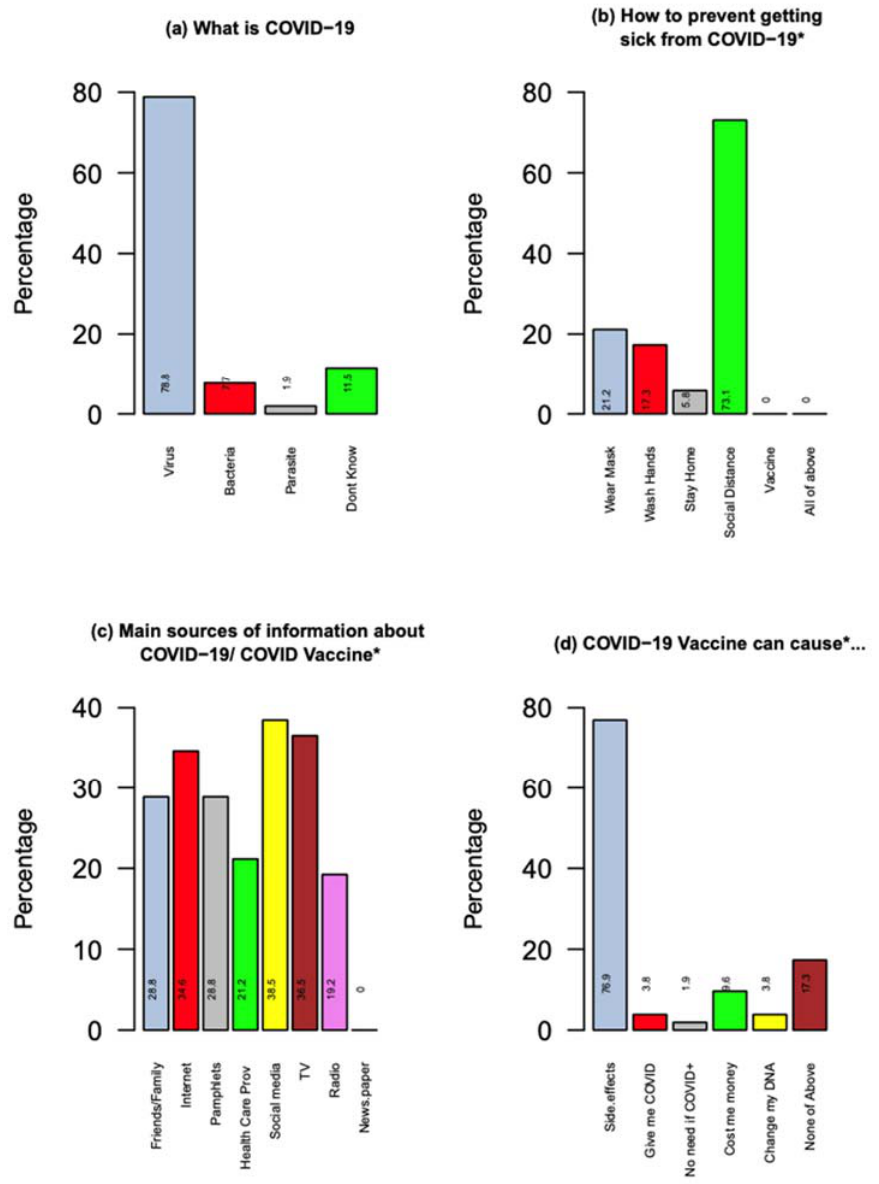
Figure 1. Distribution of Knowledge and Perceptions of COVID ‐ 19 and sources of information: ( a , b ) COVID knowledge, ( c ) sources, and ( d ) perception. * indicates multiple choice answers; the total percentages will be over 100%.